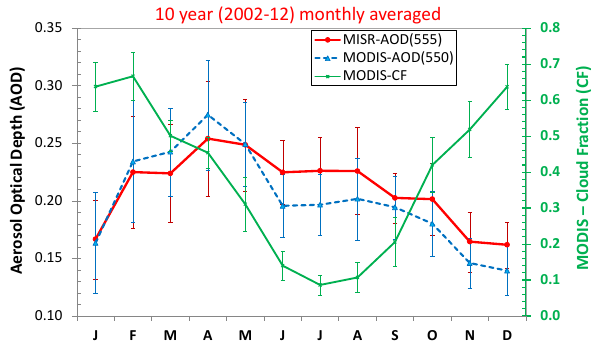
Figure 4. Seasonal variation of 10 year (2002–2012) monthly av- eraged aerosol optical depth (AOD) and cloud fraction (CF) over the ROI observed from MODIS and MISR. Error bars represent the standard deviation of inter-annual